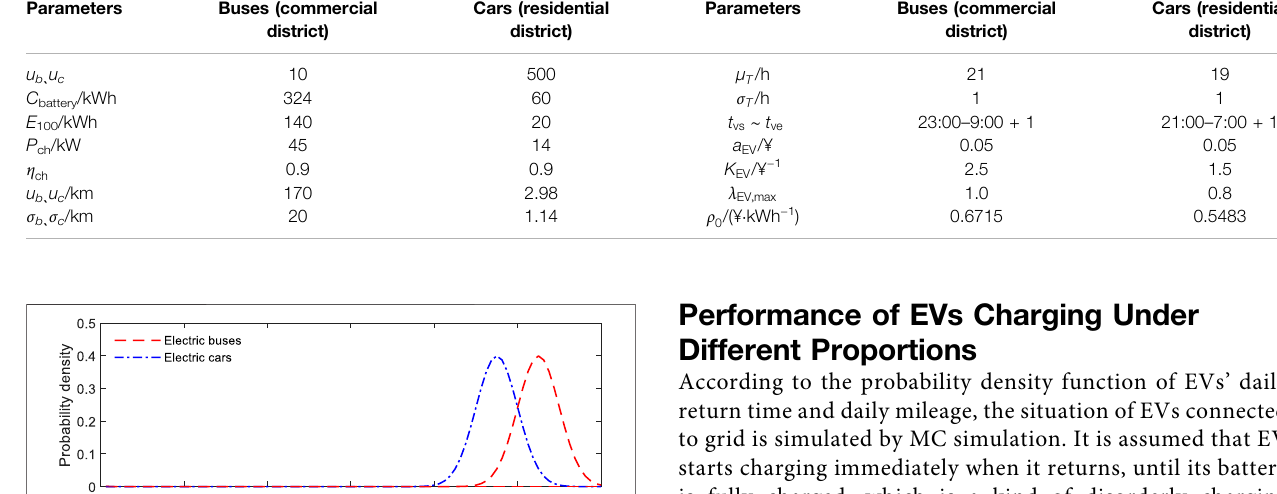
TABLE 1 | Parameters of EVs. Parameters